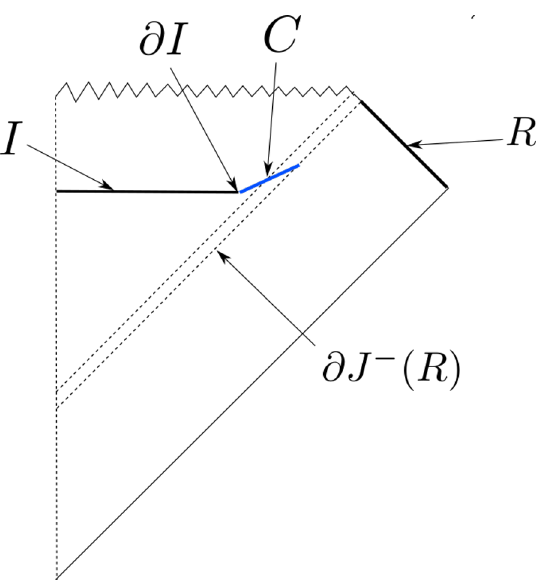
Figure 5 : An evaporating black hole in asymptotically Minkowski spacetime. C surrounds the island I , with ∂I \ ∂C = ? , and is spacelike separated from R . We show that C cannot have both width δ (cid:29) l and trace extrinsic curvature | K | (cid:28) l − 1 p p